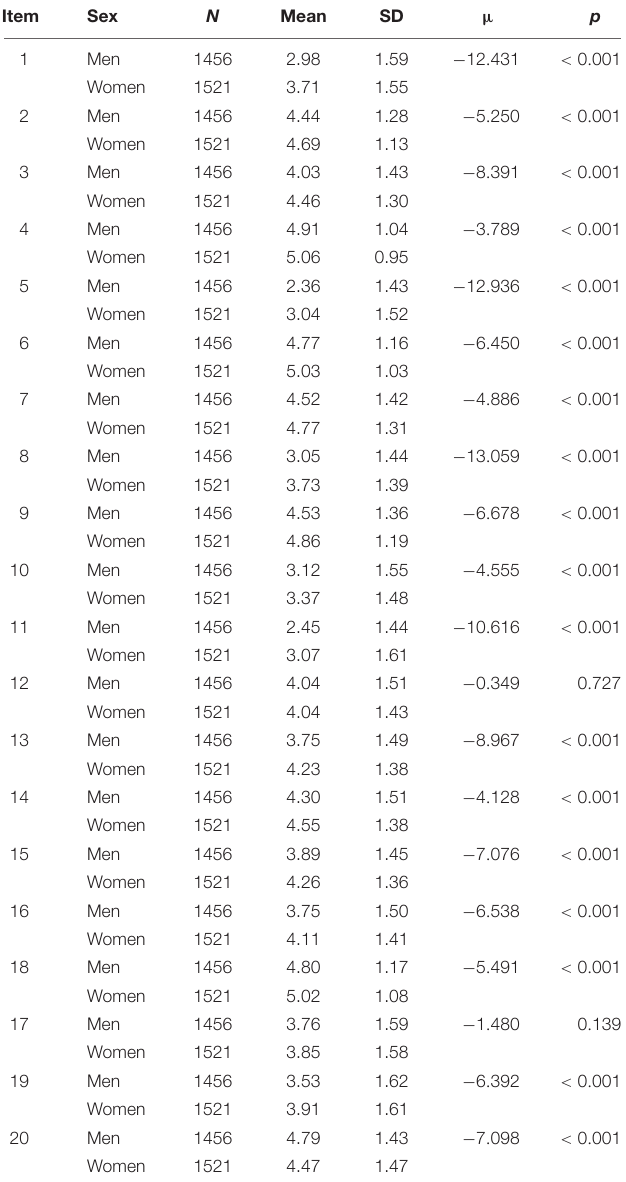
TABLE 2 | Descriptive data and gender differences on items